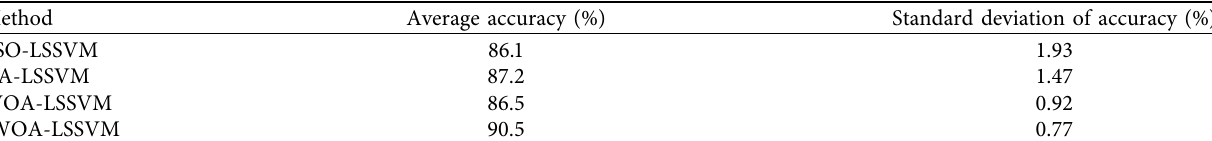
Figure 8: Fitness curve. Table 6: Diagnosis result for 10